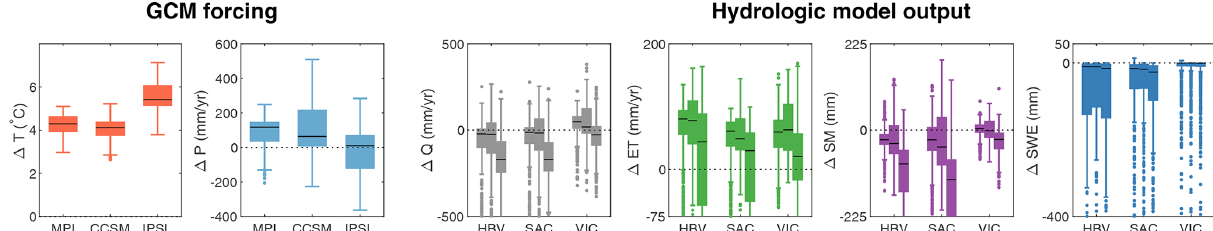
Figure 3. Changes between the historical (1985–2008) and future (2070–2093) periods. The left two panels depict the change in temperature ( (cid:49)T ) and precipitation ( (cid:49)P ) across the 605 basins, as obtained with MPI, CCSM, and IPSL (RCP8.5). The right four panels depict the change in mean discharge ( (cid:49)Q ), mean evapotranspiration ( (cid:49) ET), mean soil moisture ( (cid:49) SM), and mean snow water equivalent ( (cid:49) SWE) between both periods for the 605 basins, as simulated by the three different hydrological models and forced with the three different climate models. Each model was run for a full parameter sample per basin, and the average change across the parameter sample per basin was used to create the